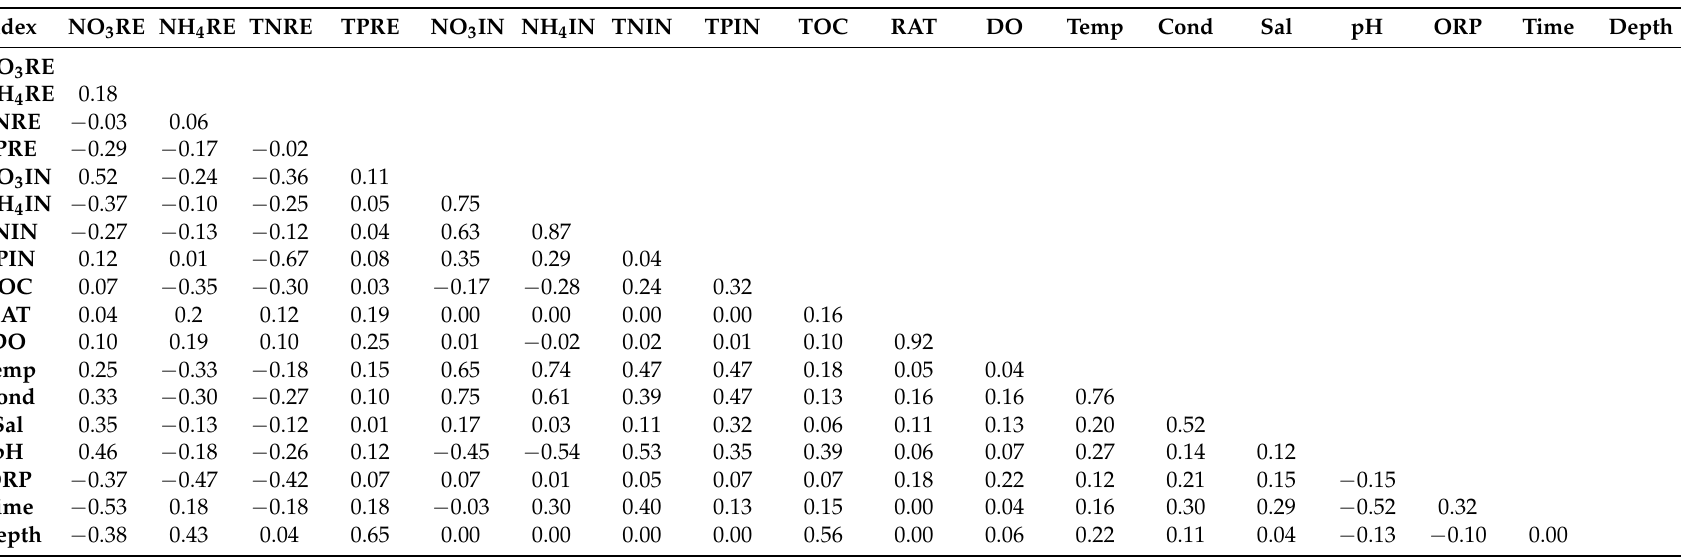
Table 4. Correlation coefficient